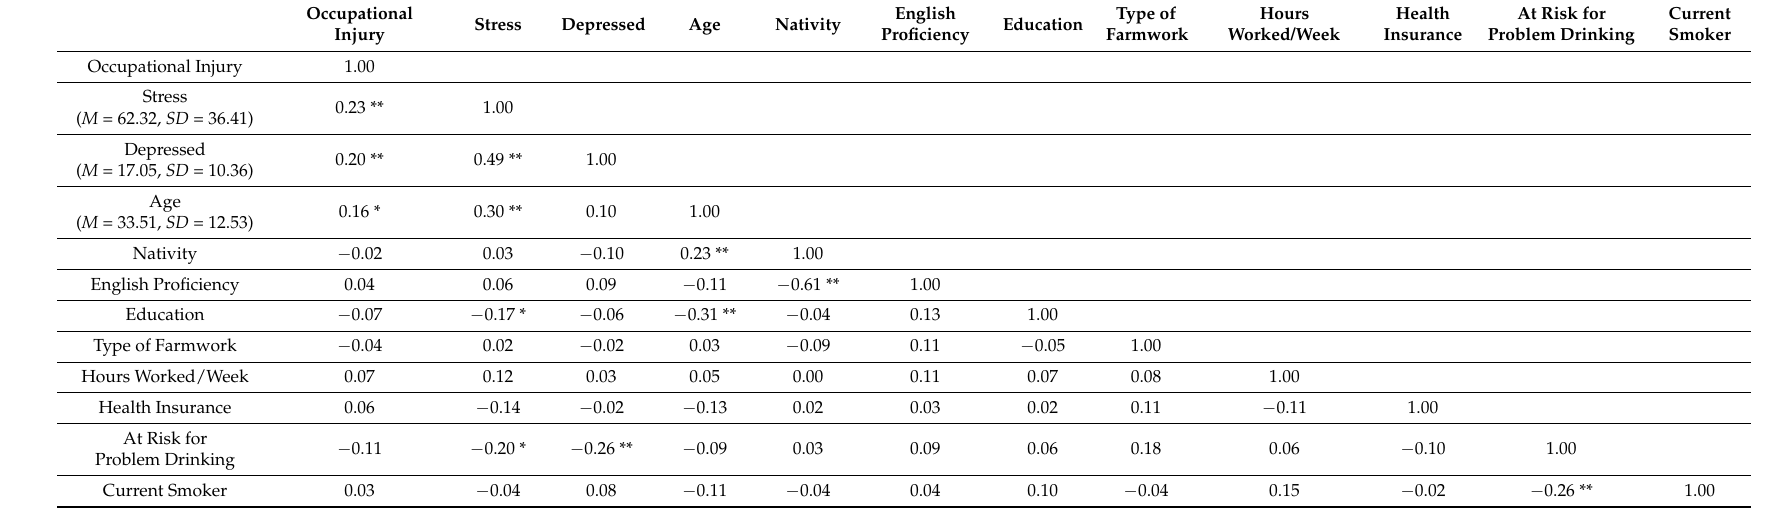
Table 2. Correlations among Study